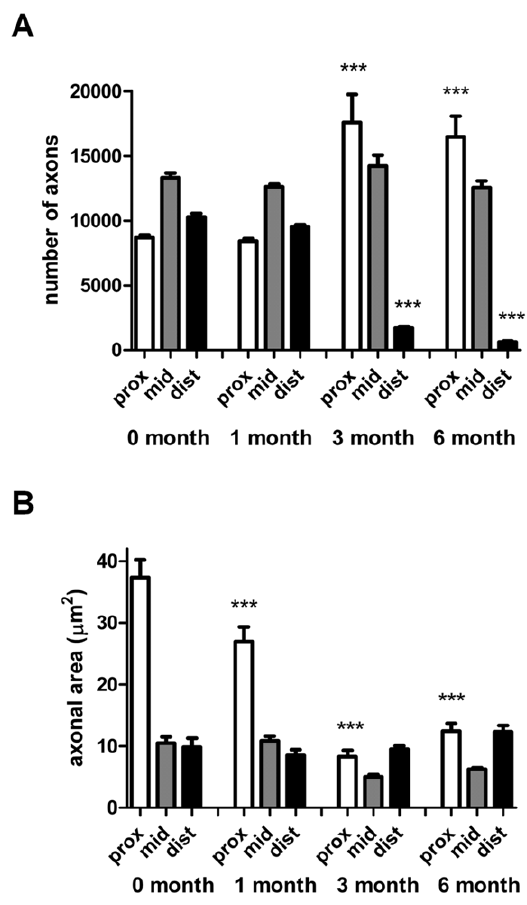
Figure 3. Quantitative analysis of (A) number of myelinated axons and (B) axonal area in the proximal stumps, mid-graft regions and distal stumps of animals undergoing sciatic nerve injury followed by either immediate or delayed nerve repair (at the time points indicated) with a 10 mm graft. Values shown are mean 6 SEM, n=5, ***p , 0.001 significantly different from respective region after immediate nerve repair.